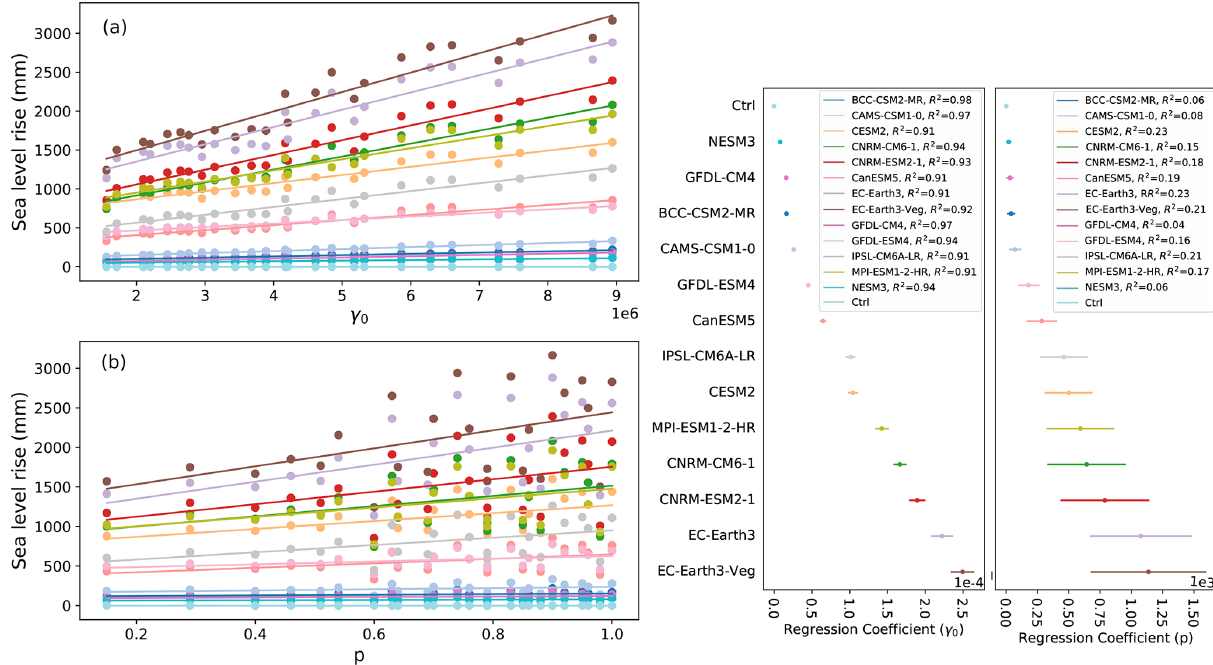
Figure 10. Continental SLR as a function of (a) γ 0 and (b) p with best linear fits. Panels on right show the regression coefficients for the model fits along with their error bars. The R 2 value associated with the best fit line is also shown in the legends.